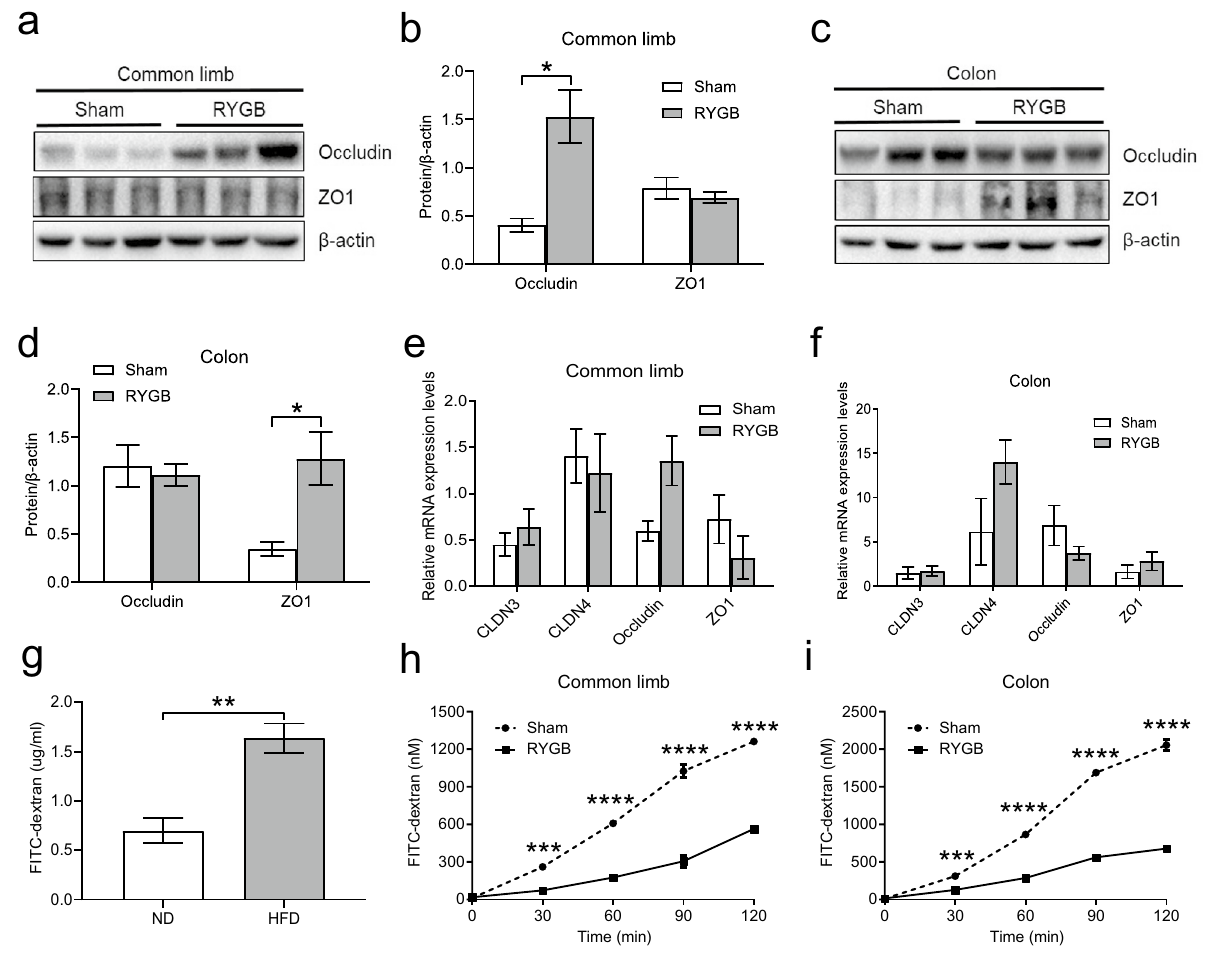
Figure 2. RYGB resulted in the restoration of gut barrier integrity. ( a , c ) The levels of TJPs in both the common limb and colon were examined by western blot. ( b , d ) Analysis of the gray image of occludin and ZO1 in both the common limb and colon between the sham group ( n = 6/group) and the RYGB group ( n = 5/group). ( e , f ) Measurement of the mRNA expression of TJPs of both the common limb and colon showed no significant difference between the groups, although the RYGB group ( n = 5/group) showed a trend of increasing occludin, ZO1 and CLDN4 levels in the common limb and colon, respectively, in comparison to the sham group ( n = 6/ group). ( g ) The comparison of intestinal permeability between the HFD group (HFD, n = 5/group) and normal control (ND, n = 5/group) was determined by FITC-dextran oral gavage. ( h , i ) The intestinal permeability of the sham group and RYGB group was measured by Ussing chamber assay. The levels of FITC-dextran in serosal buffer in both the common limb and colon were significantly lower in the RYGB group ( n = 4/group) than in the sham group ( n = 4/group). All data are the mean ± SEM. CLDN3 claudin-3, CLDN4 claudin-4, ZO1 zonula occludens-1. * p < 0.05; ** p < 0.01; *** p < 0.005; **** p <